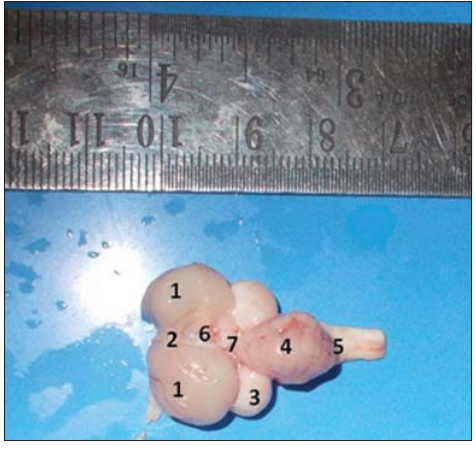
Figure-1: Dorsal view of brain showing different